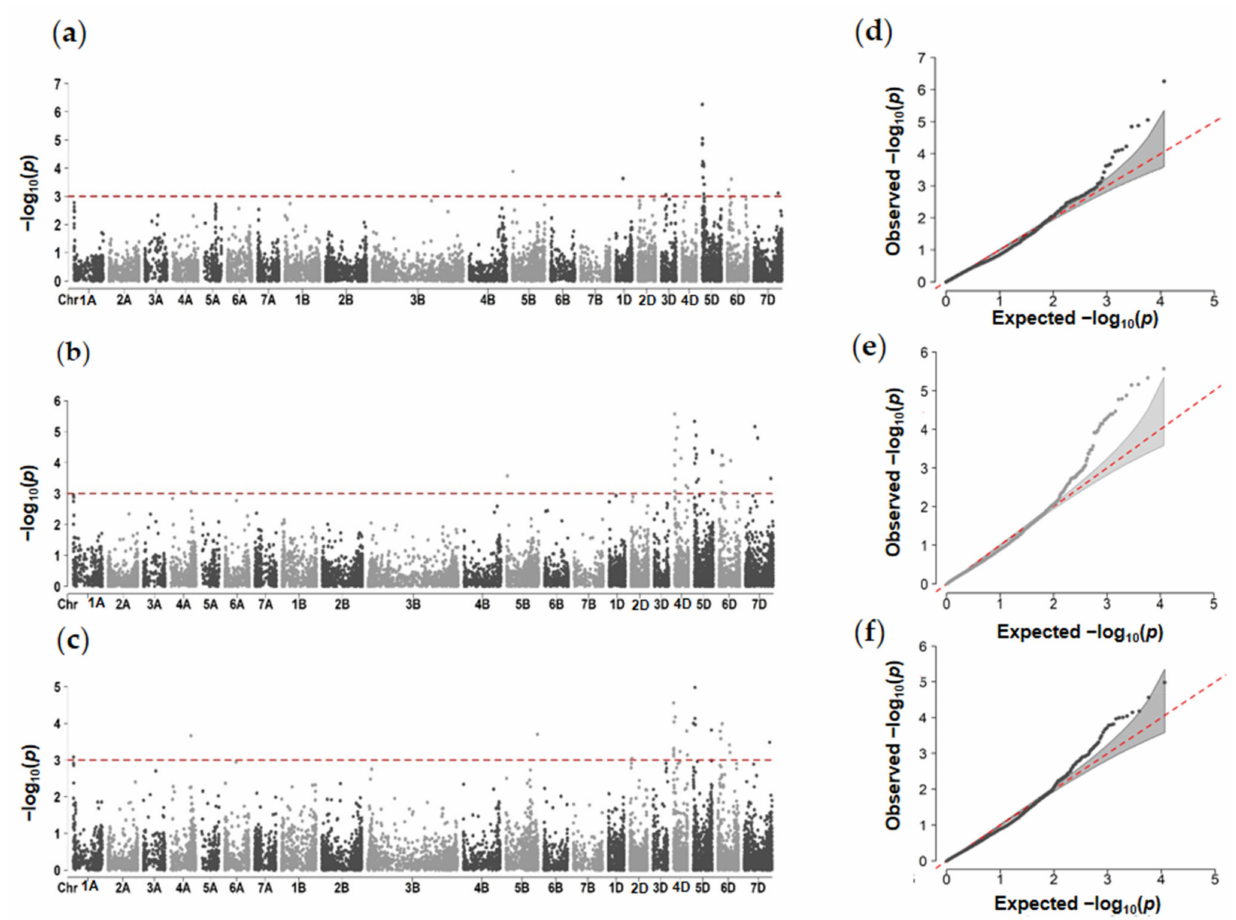
Figure 5. Manhattan for hardness ( a ) Under optimum environment, ( b ) Under heat environment, ( c ) Under combined heat-drought environment (HD), ( d – f ) Quantile–Quantile plots for hardness under optimum, heat, and